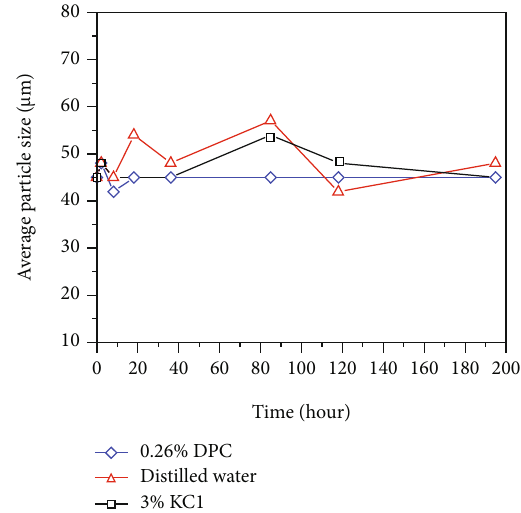
Figure 7: Geometric mean diameter change in the coal ash particles under di ff erent working